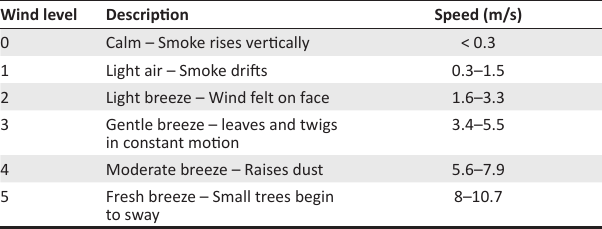
TABLE 2-A1: The Beaufort Scale was used to determine the strength of the wind (wind speed) during drone flights. Wind level